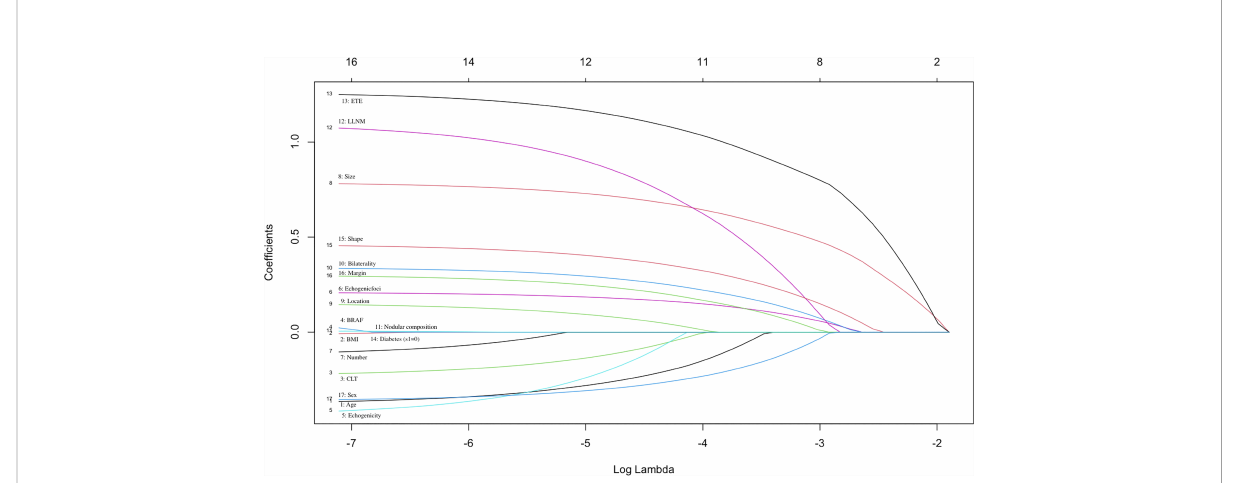
FIGURE 1 Selection of signi fi cant parameters in clinicopathologic variables in the training set. The values of the coef fi cients and the corresponding lambda values, each curve represents each feature in the